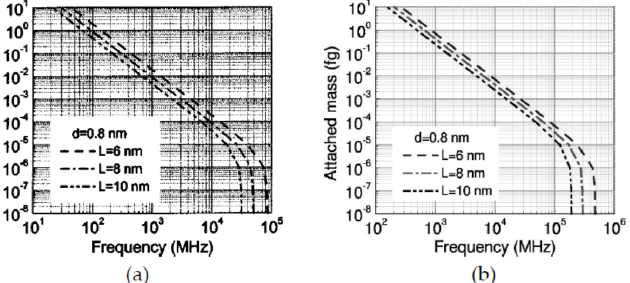
Figure 5. Fundamental frequency of ( a ) cantilevered and ( b ) bridged carbon nanotube resonators with different length L vs. attached mass. Adapted with permission for [126], copyright AIP Publishing, 2004.